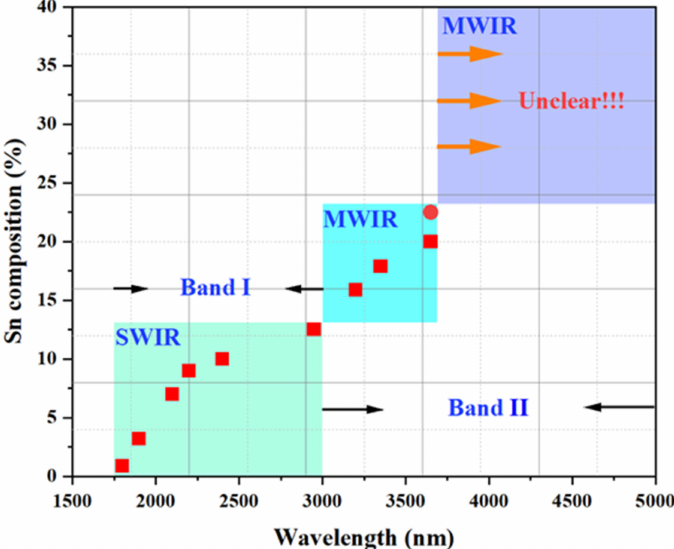
Figure 19. Sn content vs. wavelength of a GeSn photoconductive detector, indicating that GeSn is a promising absorber in SWIR and MWIR detection